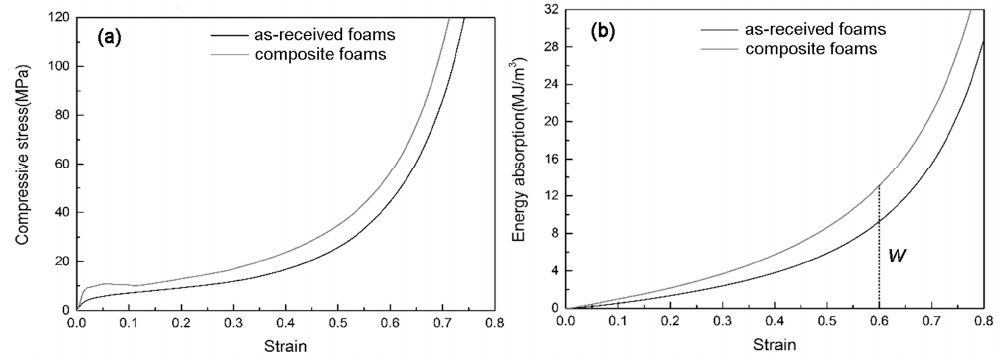
Figure 7. Compressive properties of the Al foams and composite foams at room temperature: ( a ) compressive curves; ( b ) energy absorption.